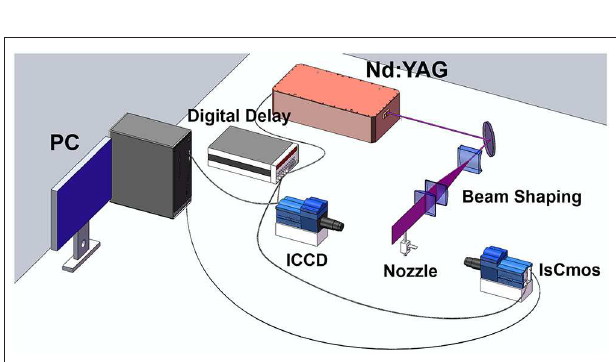
FIGURE 2 | Schematic diagram of oxygen concentration distribution in the nozzle flow field.